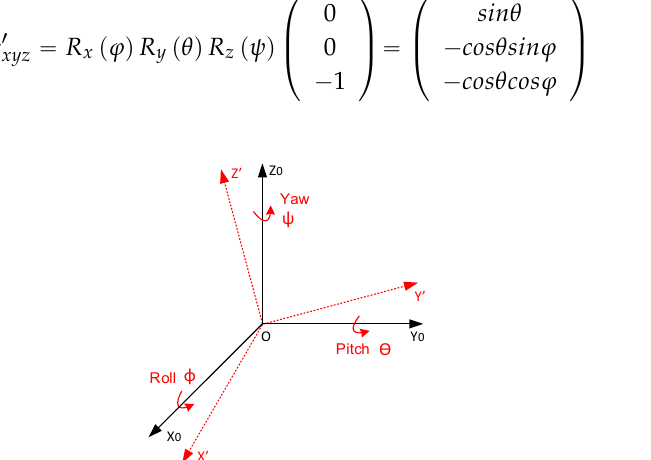
Figure 4. Coordinate System Transforming Through the Order of X-Y-Z (modified from [11]). The initial coordinate system OX 0 Y 0 Z 0 is transformed to OX 1 Y 1 Z 1 considering the roll, pitch and yaw angles around the x-, y- and z-axis respectively.